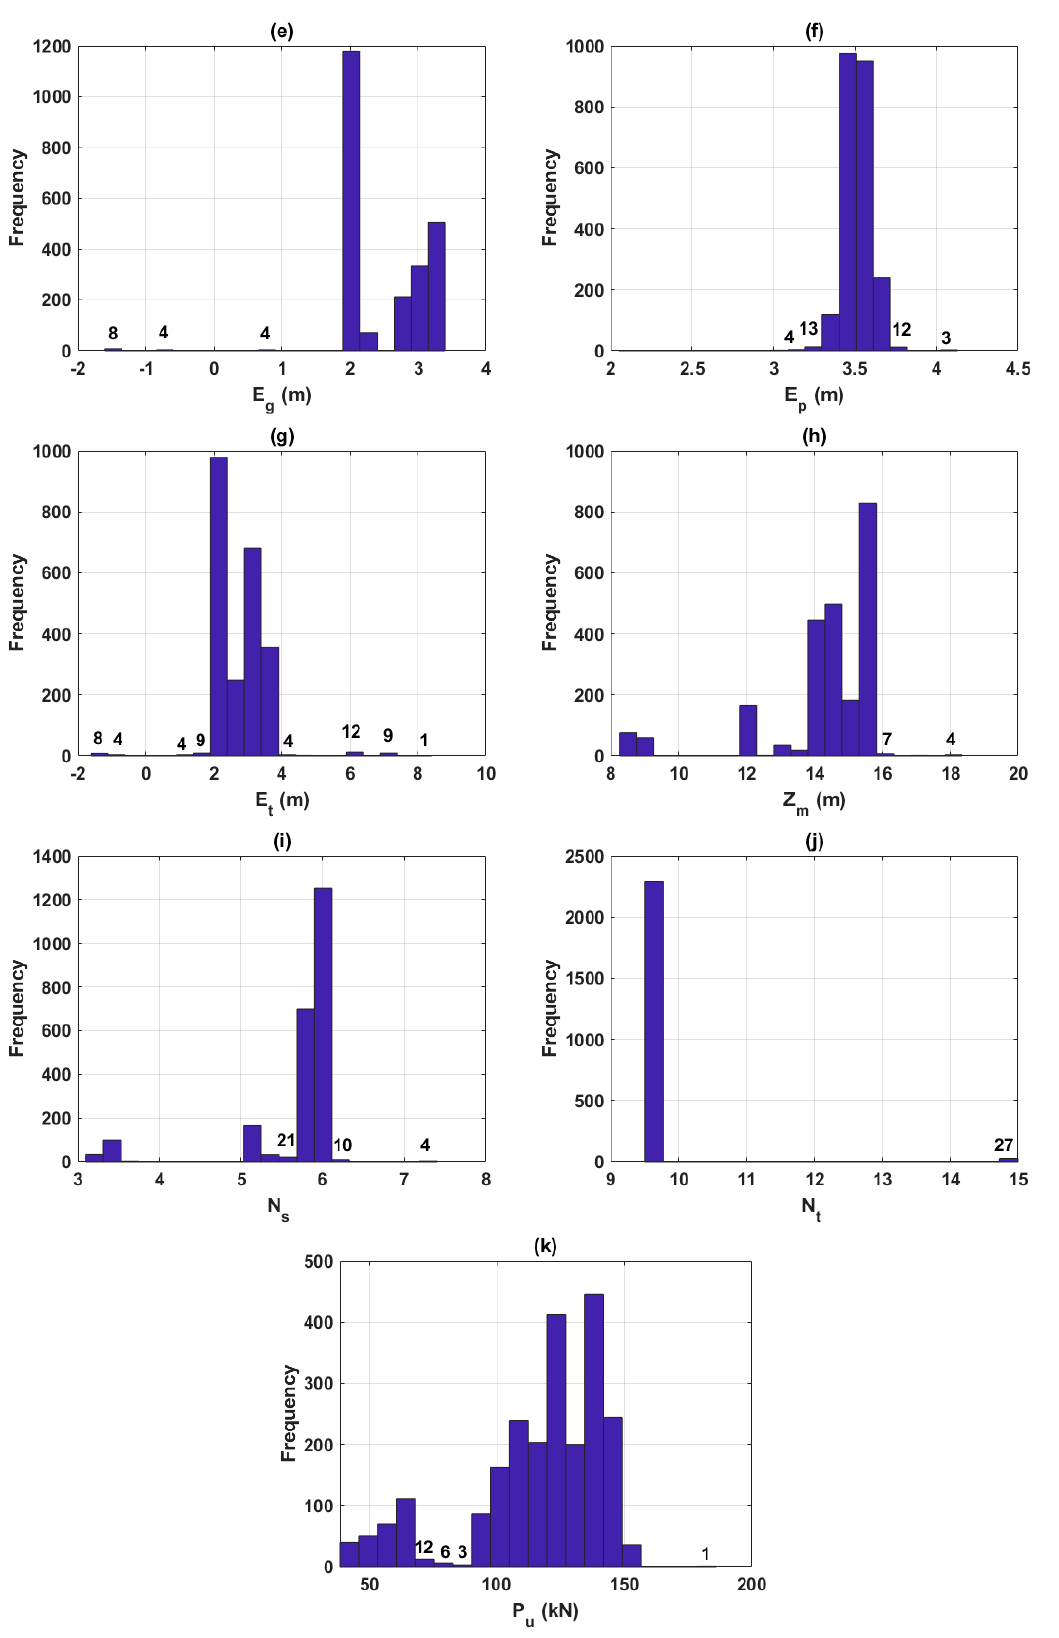
Figure 3. Histograms of the dataset in this study: ( a ) D; ( b ) L 1 ; ( c ) L 2 ; ( d ) L 3 ; ( e ) E g ; ( f ) E p ; ( g ) E t ; ( h )Z m ; ( i ) N s ; ( j ) N t ; ( k ) P u .